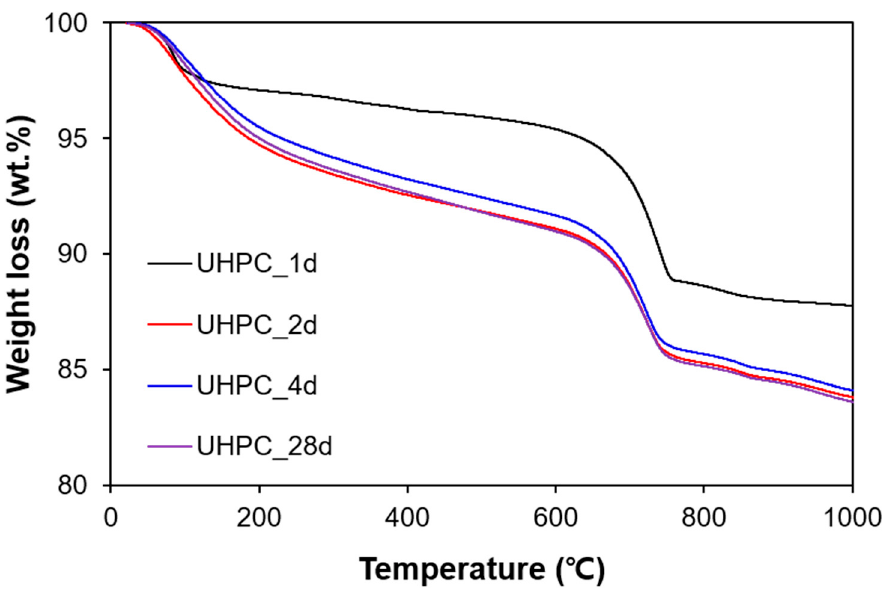
Figure 3. Compressive strength of the specimens .